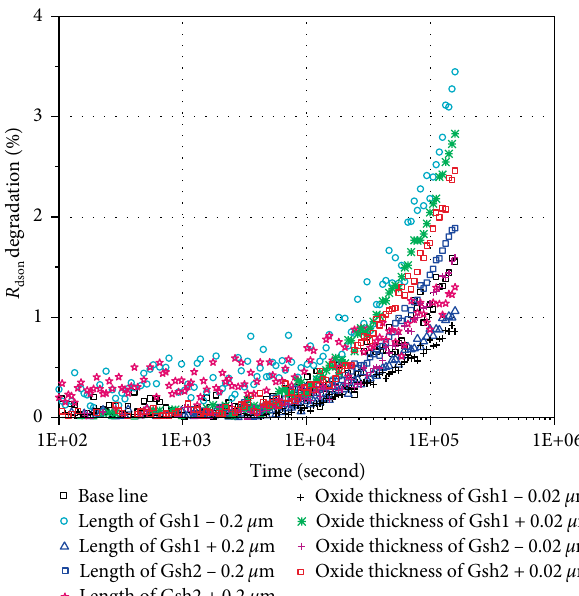
Figure 8: On resistance degradation during HCI testing.